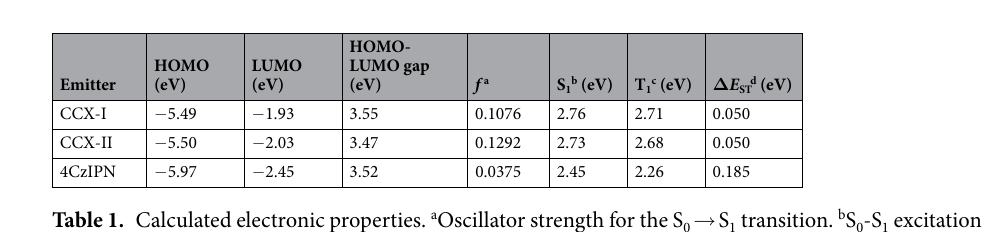
Table 1. Calculated electronic properties. a Oscillator strength for the S 0 → S 1 transition. b S 0 -S 1 excitation energy. c S 0 -T 1 excitation energy. d Energy difference between S 1 and T 1